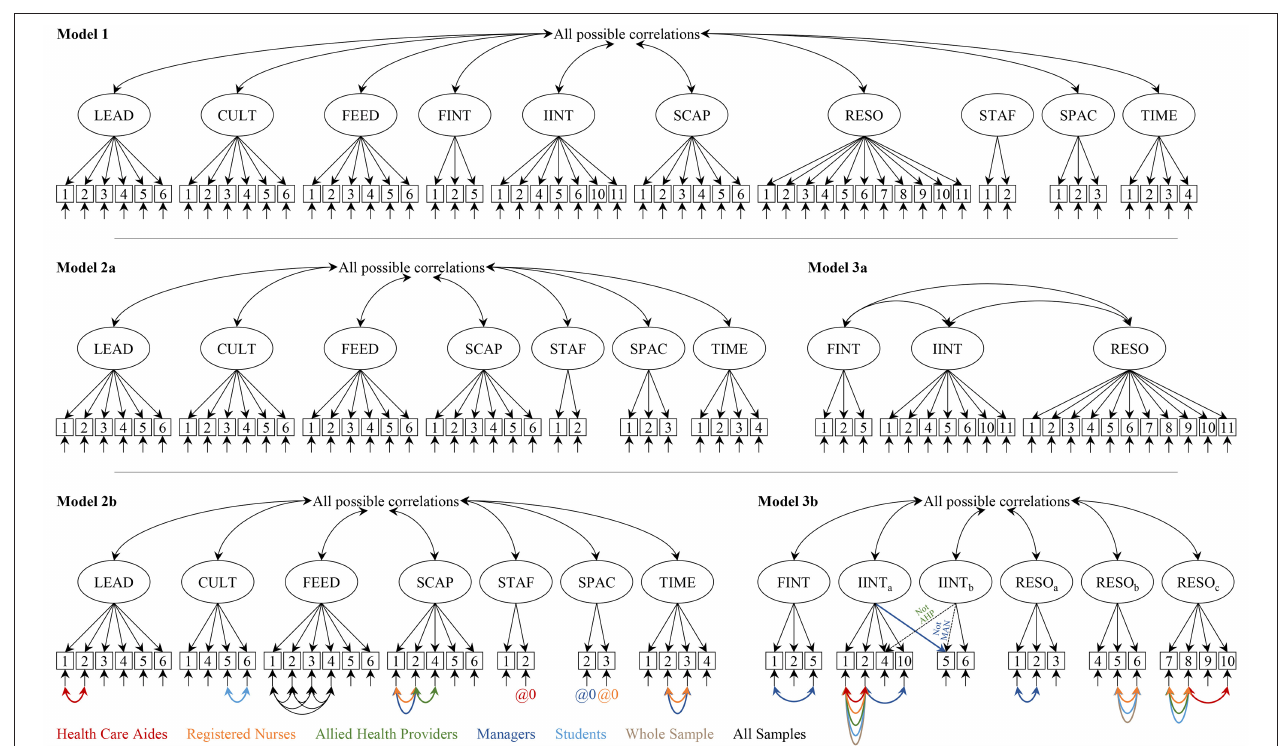
FIGURE 2 | Alberta Context Tool factor models.